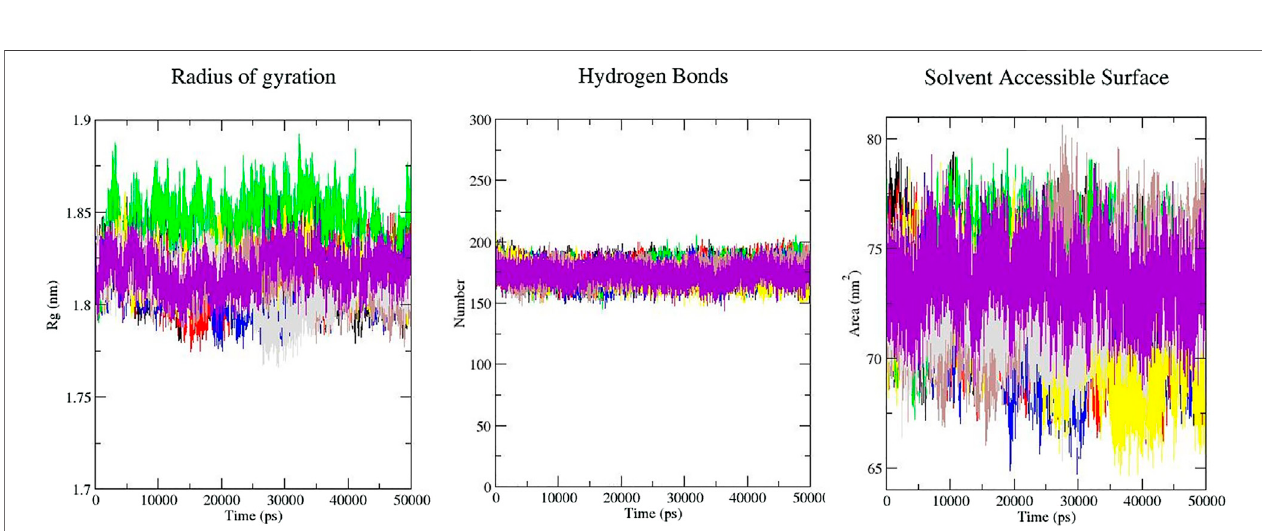
FIGURE 2 | Rg, intramolecular hydrogen bonds, and SASA plots of SENP2 complexes, black) free-SENP2, red) GA, green) CA, blue) TQ, yellow) Betanin, brown) Betanidin, gray) Ebselen, and purple) Fisetin.